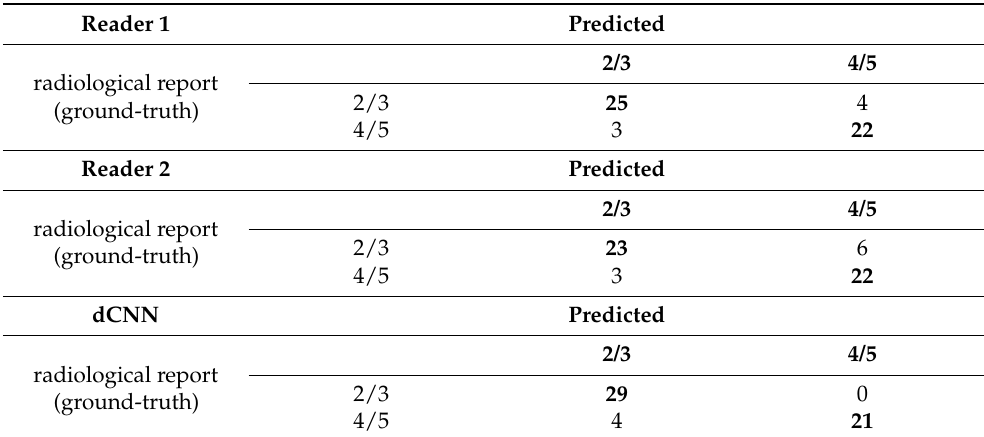
Table 3. Confusion matrices for reader 1, reader 2 and dCNN model 3 for classification to BI-RADS 2/3, “probably benign soft tissue opacities”, and BI-RADS 4/5,“suspicious soft tissue opacities” on the “real world” dataset. Correctly assigned classes are highlighted in bold.